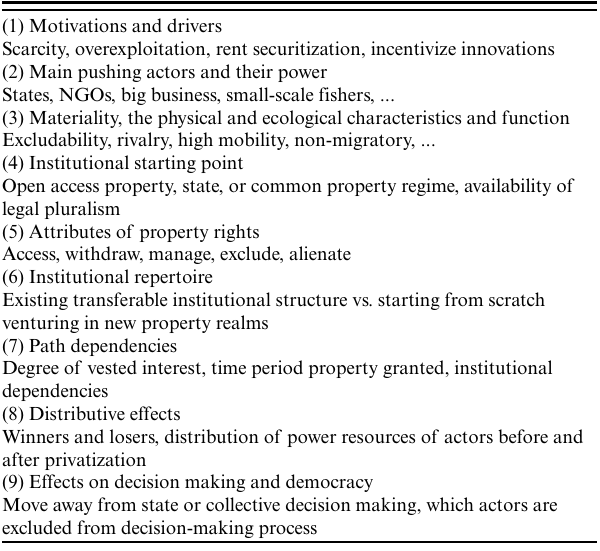
Table 1 . Criteria for assessing ocean